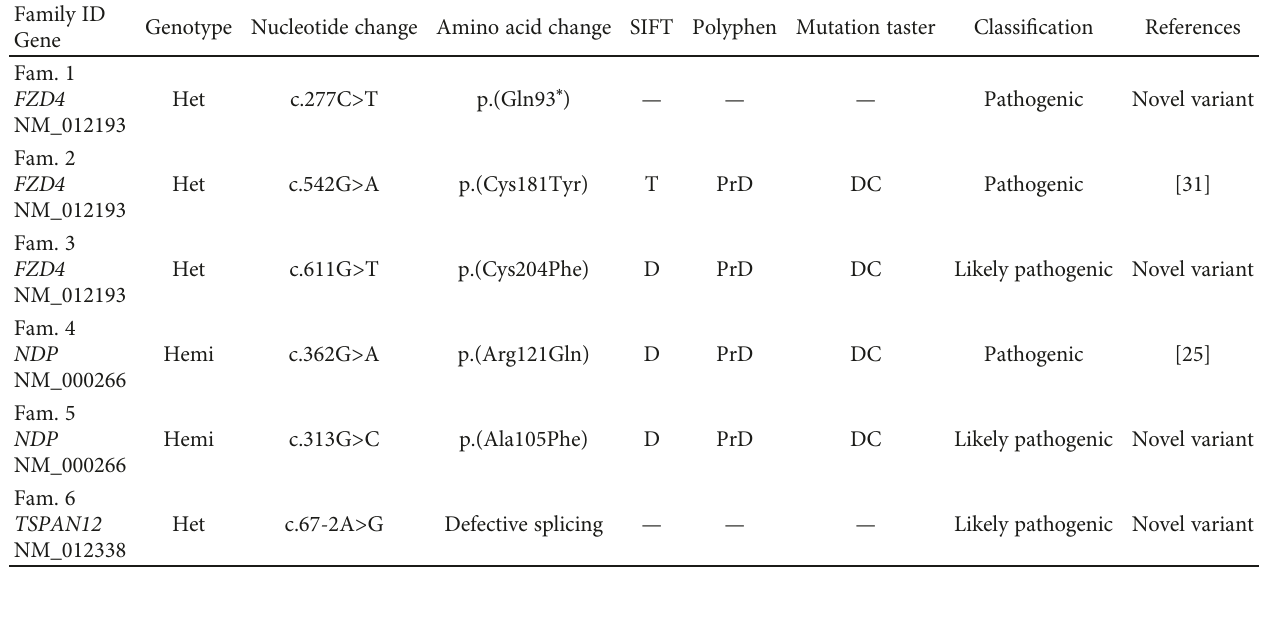
Table 1: Features of genetic variations found in FEVR families.